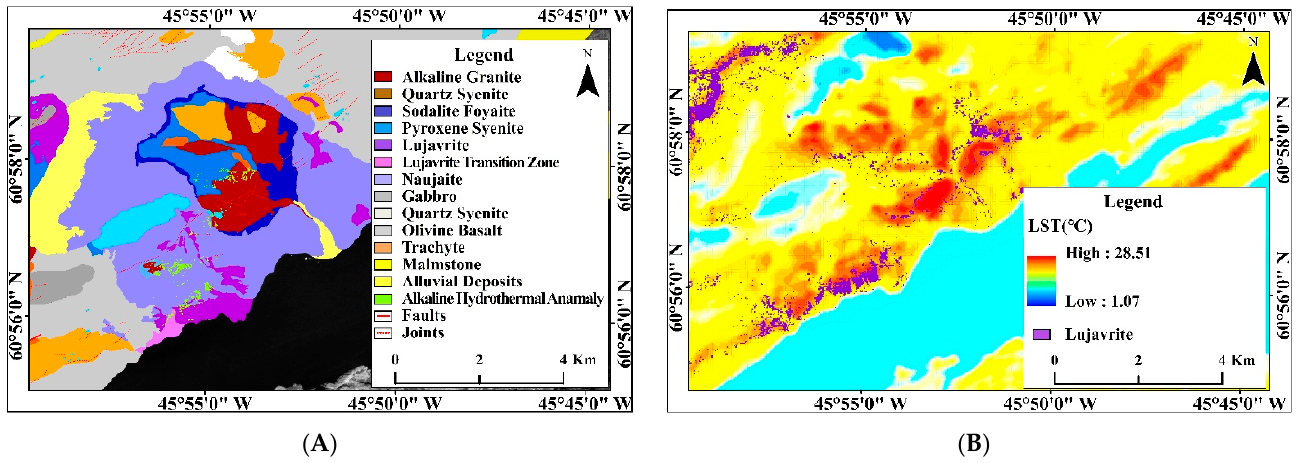
Figure 16. ( A , B ) Mineral prospecting target area analysis map.